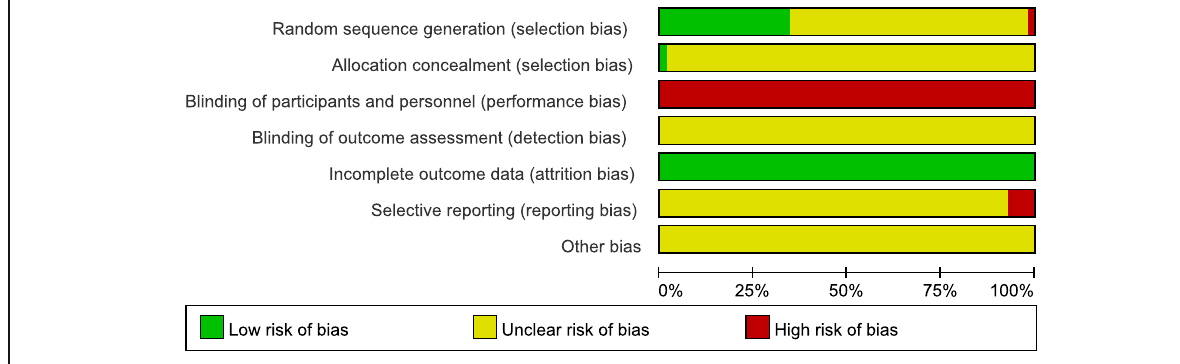
Treatment efficacy FEV1